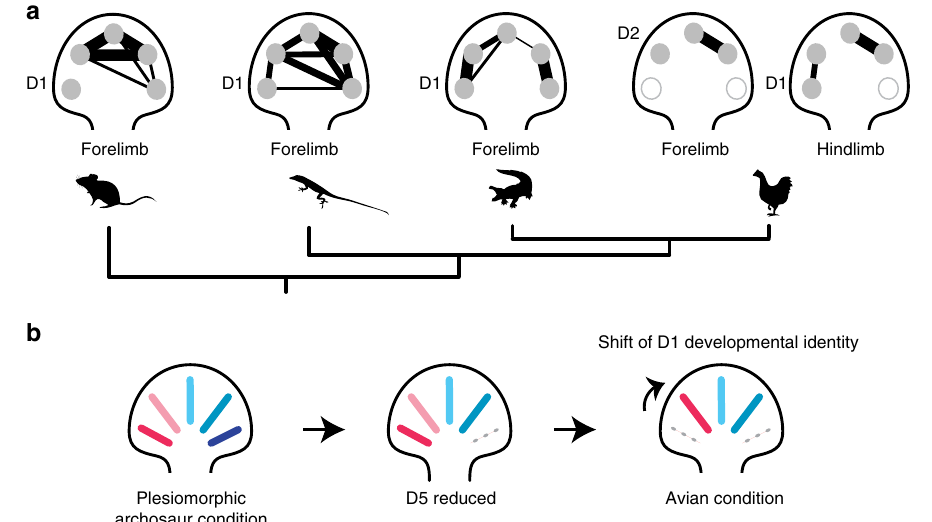
Fig. 7 The evolution of digit gene expression in amniotes is highly dynamic. a A phylogeny of the taxa sampled by this study and schematic graphs summarizing the relative similarity of digits within limbs, where connections and line thickness re fl ect degree of similarity in gene expression pro fi les. b Schematic of a limited frame shift model for evolutionary origin of the avian wing in which the developmental identity of D1 was translocated to position D2. Alligator and chicken illustrations reproduced with permission by Michael Richardson. Anolis illustration by Sarah Werning without modi fi cation (license